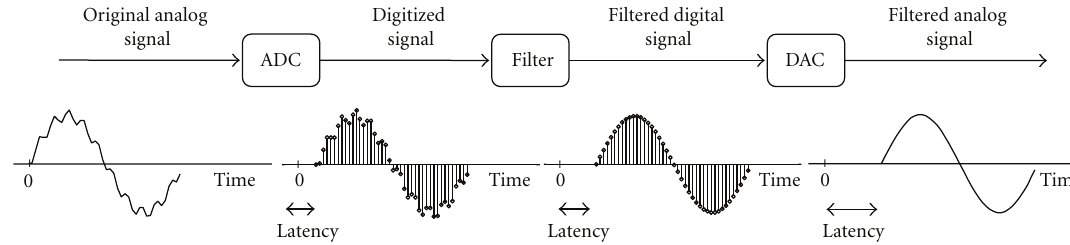
Figure 9: Basic functionality and latency of a digital filter.